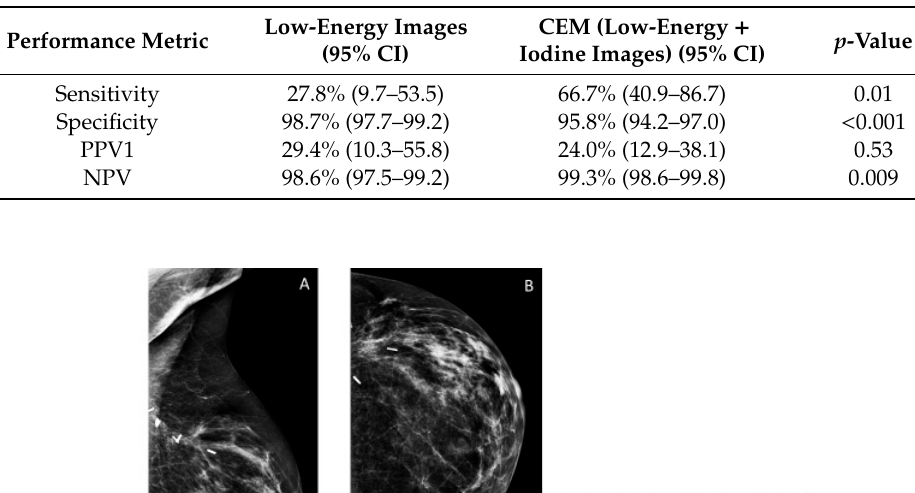
Table 4. Comparison of the performance metrics of low-energy images and CEM combining low-energy and iodine images for 917 CEM exams with 1-year follow-up. Interval cancers were included. Recommendations for diagnostic MRI included as a positive result. PPV1: positive predictive value and NPV: negative predictive value.